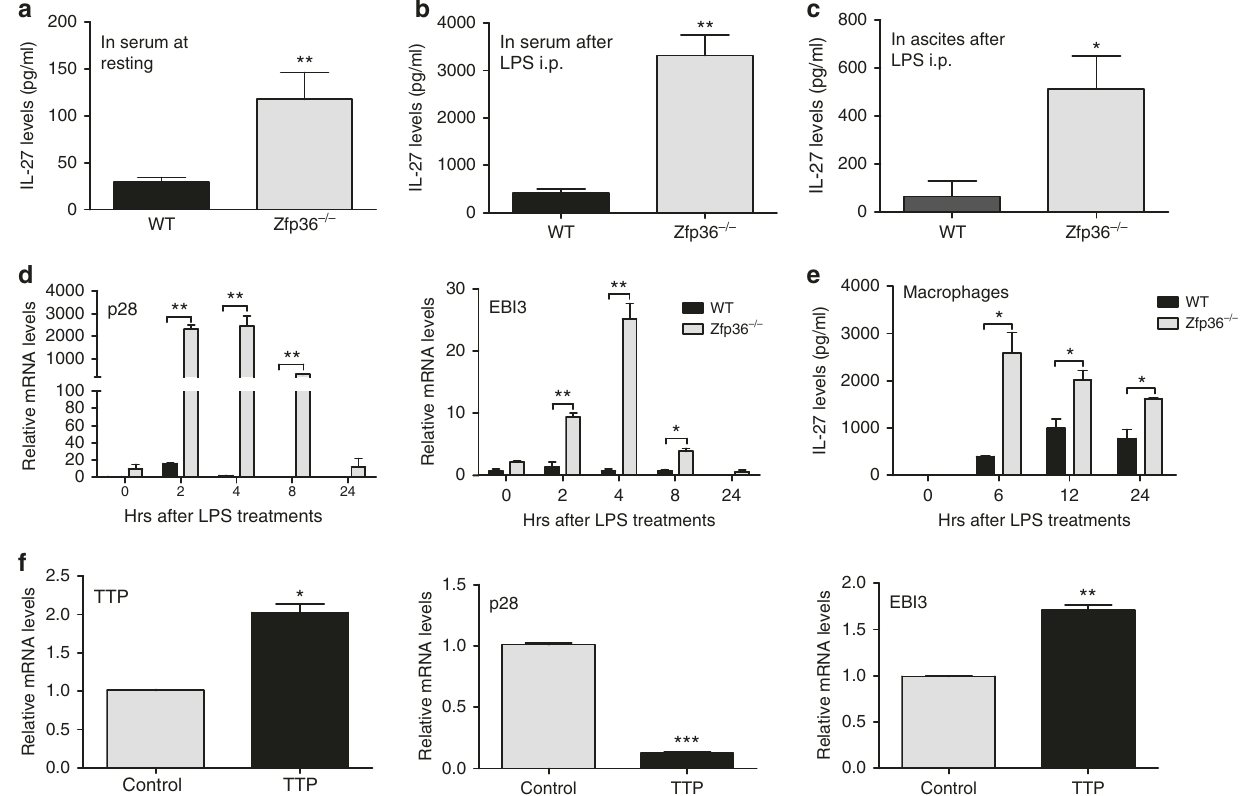
Fig. 3 TTP inhibits IL-27 expression. a – c IL-27 levels in serum and ascites of WT and Zfp36 − / − mice treated (7 mice per group) or not treated (3 mice per group) with LPS for 4 h were detected by ELISA. d Peritoneal macrophages of WT and Zfp36 − / − mice were stimulated by LPS for different times as indicated. Then the mRNAs of p28 and EBI3 were detected by qRT-PCR. The data were normalized relative to GAPDH mRNA levels and further normalized to the results from WT group at 0 h ( n = 3). e Culture supernatants of the cells as in d were used to measure IL-27 p28 protein by ELISA ( n = 3). f J774A.1 cells were infected by control or TTP-expressing lentivirus for 72 h, and then stimulated by LPS for 4 h. The mRNA expression of TTP, p28 and EBI3 were detected by qRT-PCR. The data are normalized relative to GAPDH mRNA levels and further normalized to the results from control group ( n = 3). Results shown are means ± s.d. and analyzed by unpaired student ’ s t -test as in a – f , * p < 0.05; ** p < 0.01, *** p < 0.001 vs.